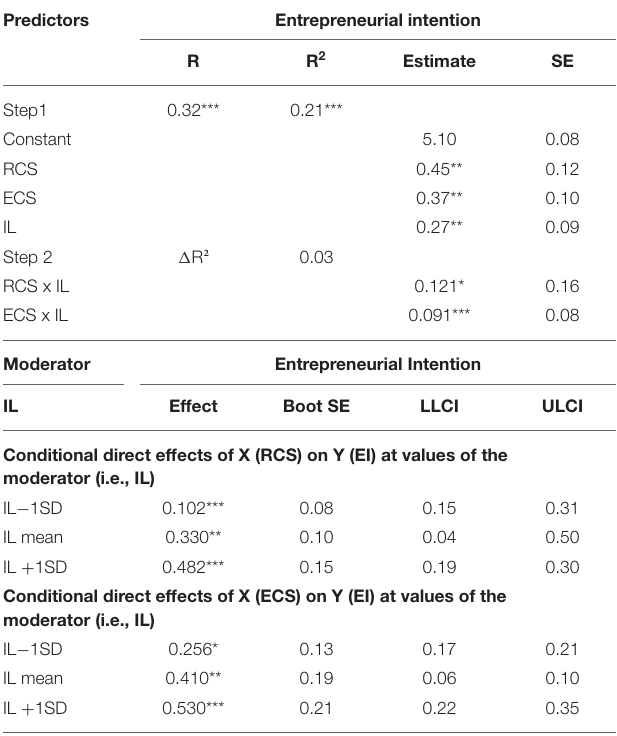
TABLE 4 | Hierarchical moderated regression analysis. Predictors